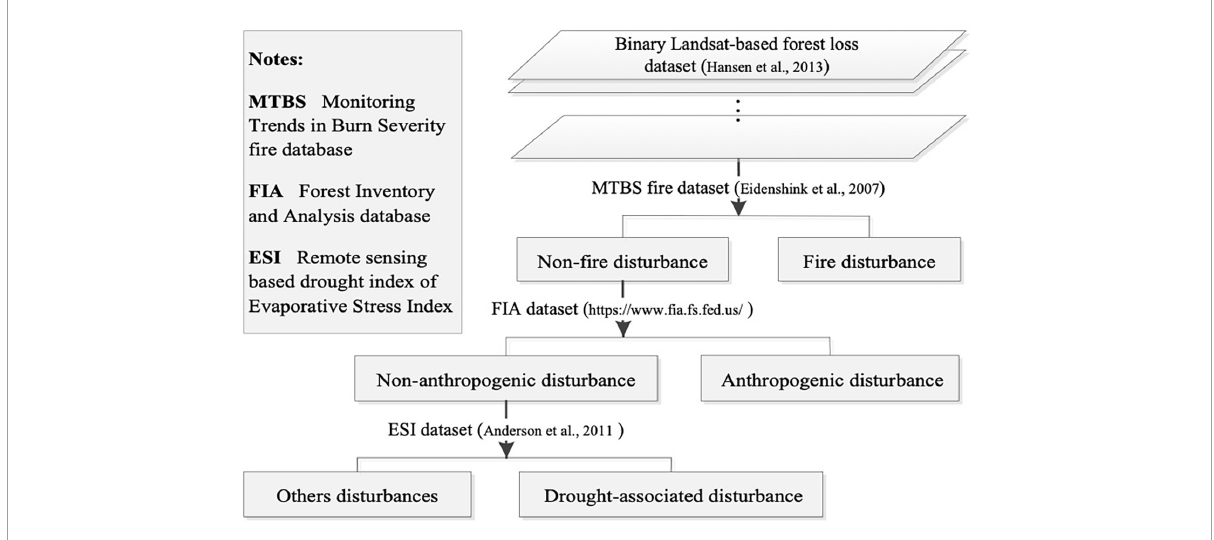
FIGURE1 Workflow for the attributions of fire-caused, anthropogenic (especially timber harvest) and drought-associated disturbances.